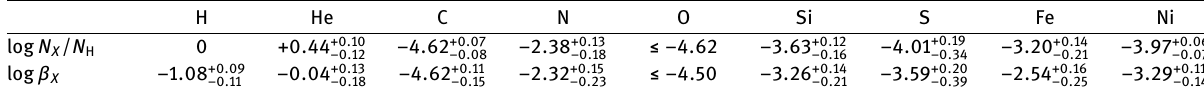
Table 3. Abundance results by number (log N X / N H ) and mass fraction ( β X ) with standard deviation errors from single